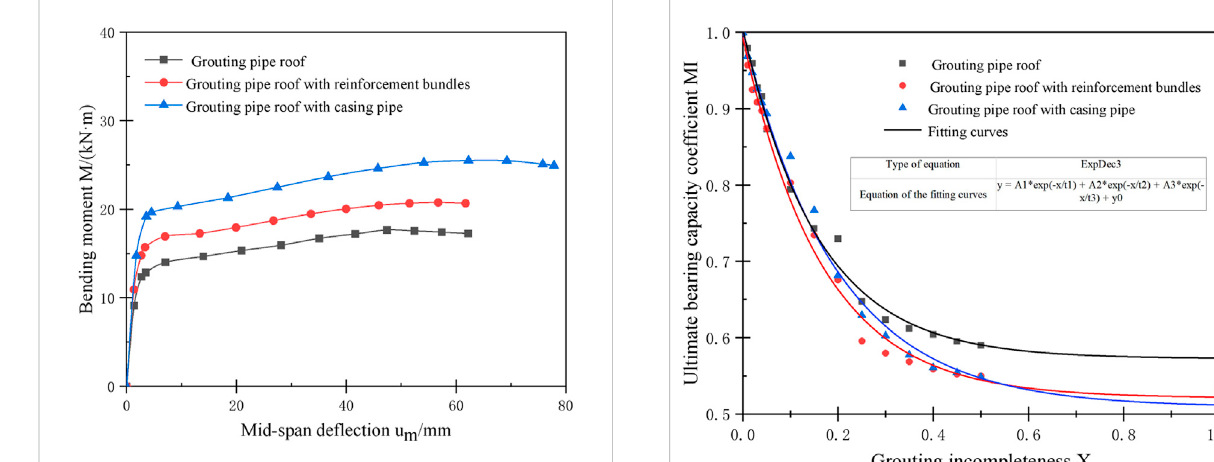
FIGURE 6 Bending moment — mid-span de fl ection curve of three types of pipe roof under full grouting.